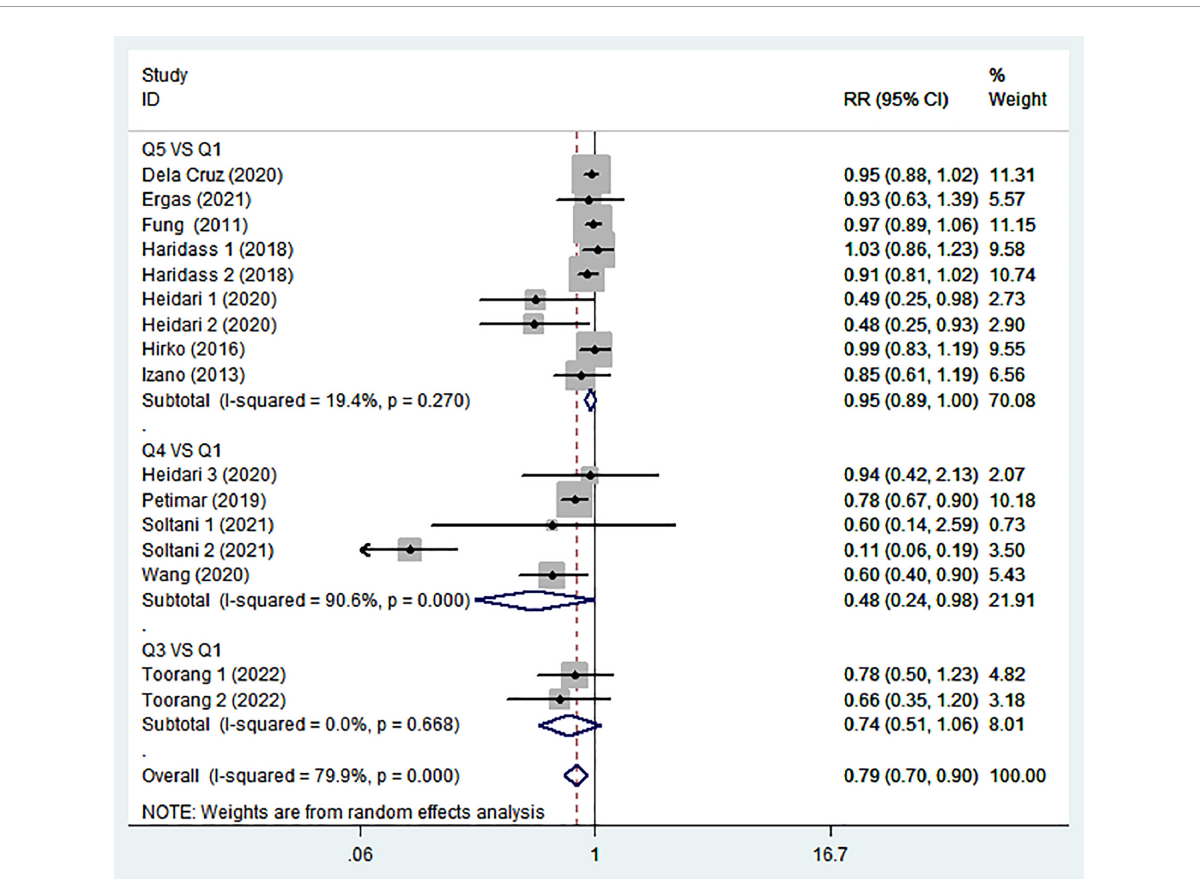
FIGURE6 Meta-analysis on the association between adherence to dietary approaches to stop hypertension (DASH) diet and breast cancer risk stratified by